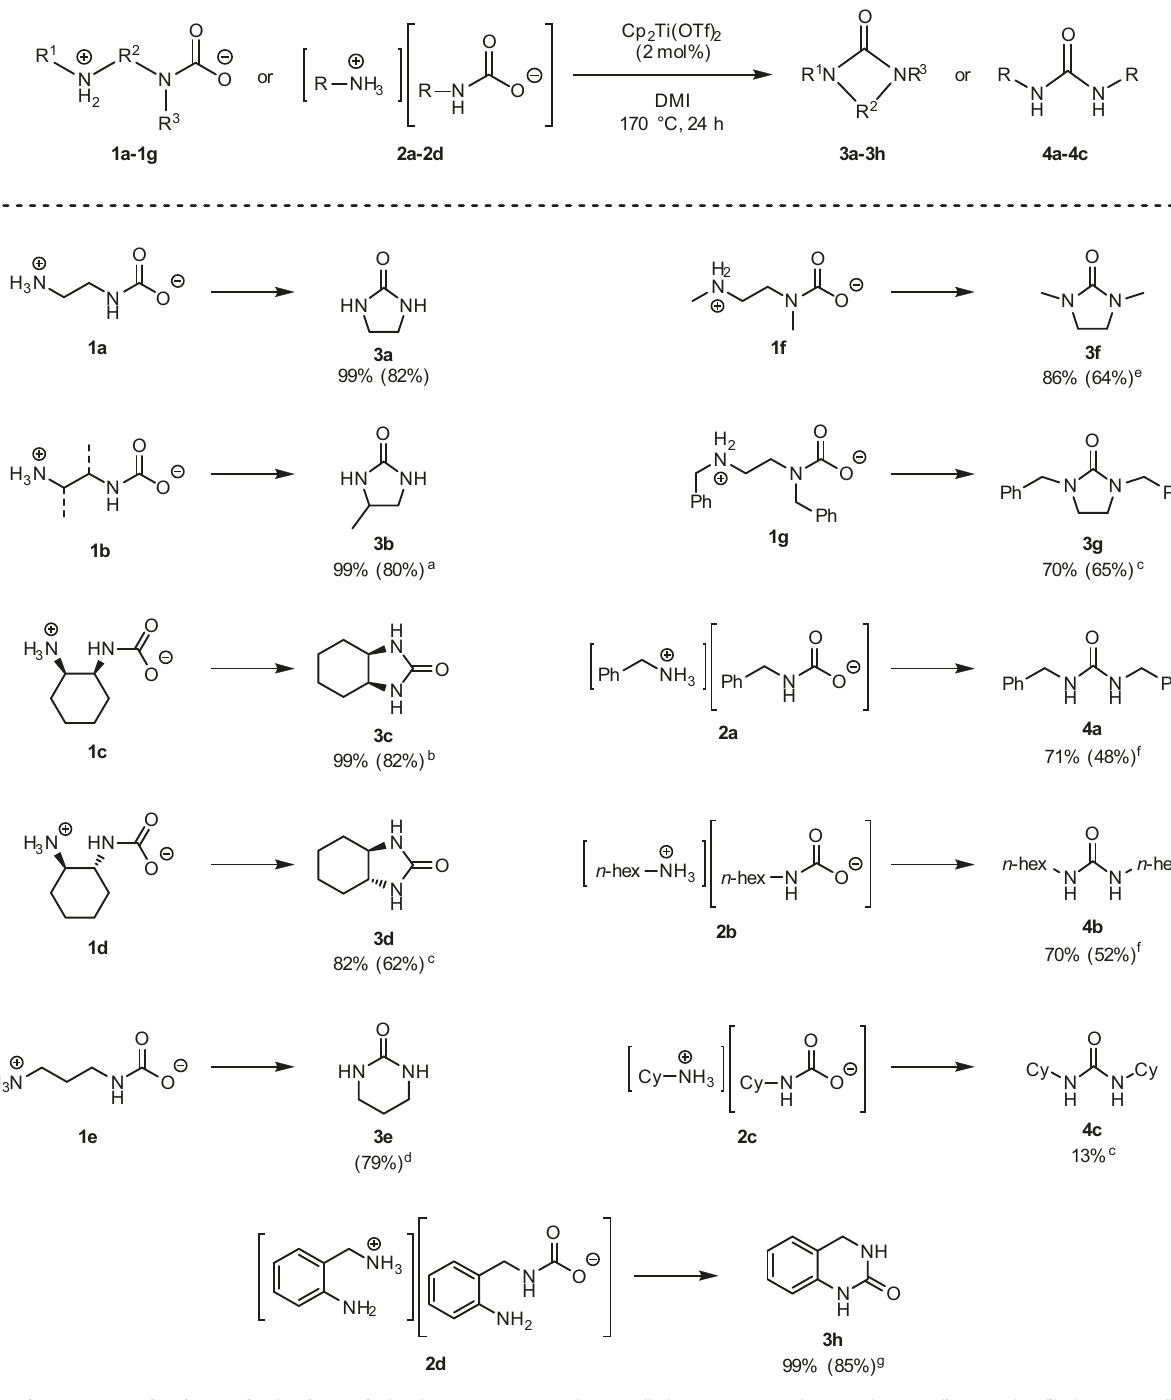
Fig. 4 Substrate scope for the synthesis of urea derivatives. Reaction conditions: alkyl ammonium carbamate (10 mmol), Cp 2 Ti(OTf) 2 (0.04 mmol), DMI (4.5 mL), and 5 mL sealed reaction vessel. Values in parentheses indicate isolated yields. a Tentative isolated yield if pure 1b was used. b 8 mmol of 1c and 4 mL of DMI were used. c 2 mmol of alkyl ammonium carbamates and 10 mol% of Cp 2 Ti(OTf) 2 were used for 15 h. d NMR yield could not be determined due to low solubility. e 1,4-dioxane was used as the solvent instead of DMI for 24 h. f 2 mmol of alkyl ammonium carbamate and 10 mol% of Cp 2 Ti(OTf) 2 were used for 48 h. g 4.6 mmol of 2d and 4 mL of DMI were